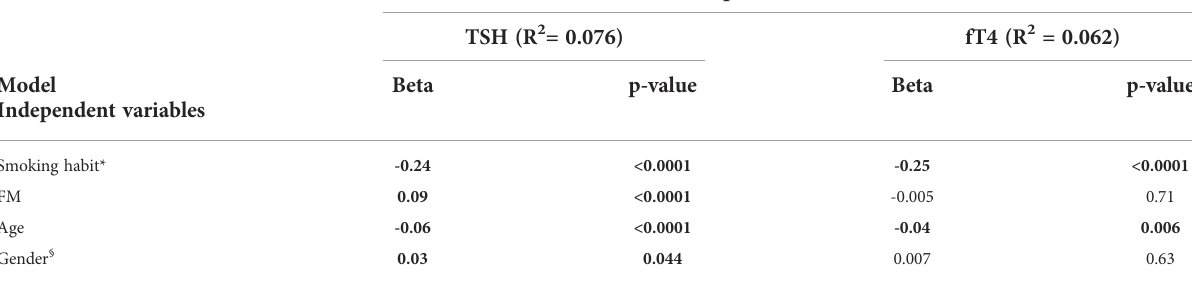
TABLE 4 Multivariable linear regression analysis showing independent predictors for TSH and fT4 levels.